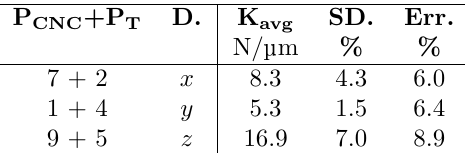
Table 10: Approximate 5-axis stiffness: combination of 3-axis CNC stiffness (test 1.3) and 2-axis trunnion stiffness, in x, y and z-direction.